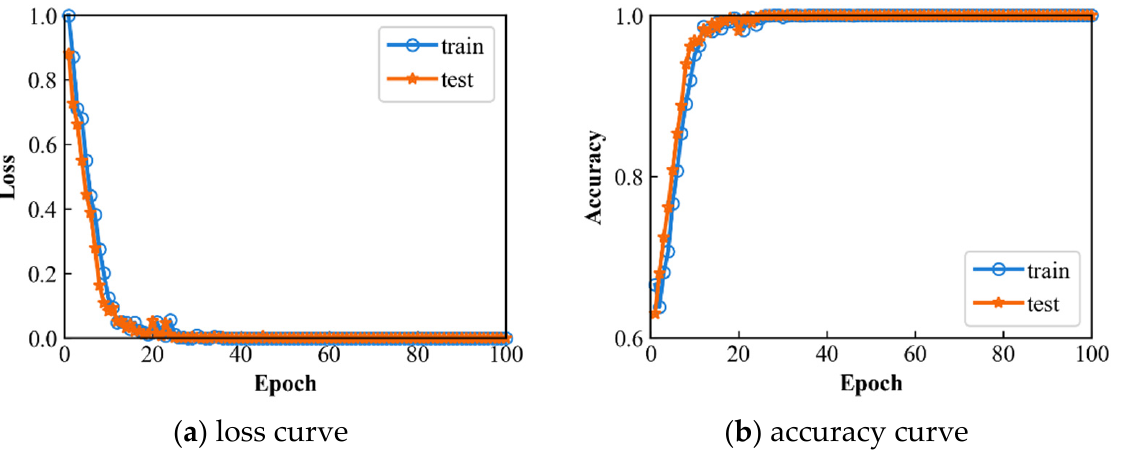
Figure 4. Loss and accuracy curve of federated fault diagnosis model.